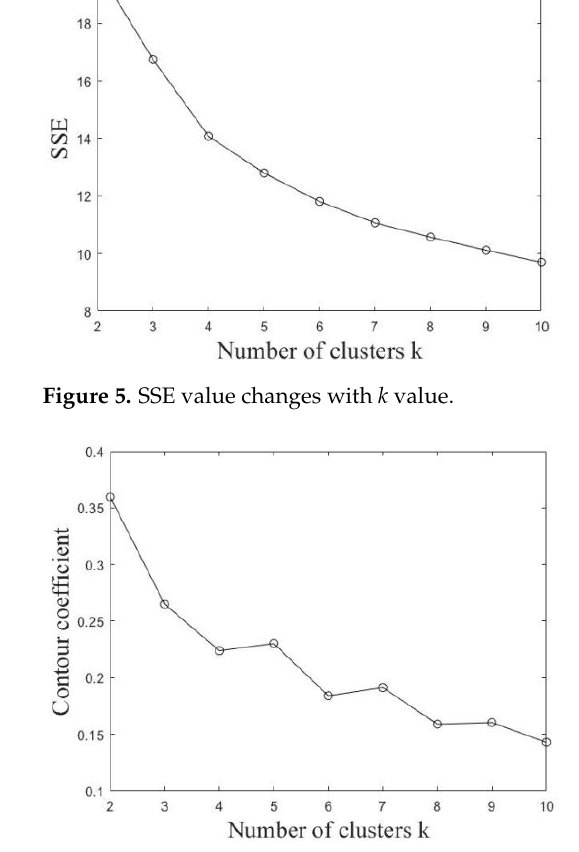
Figure 6. Contour coefficient changes with k value.